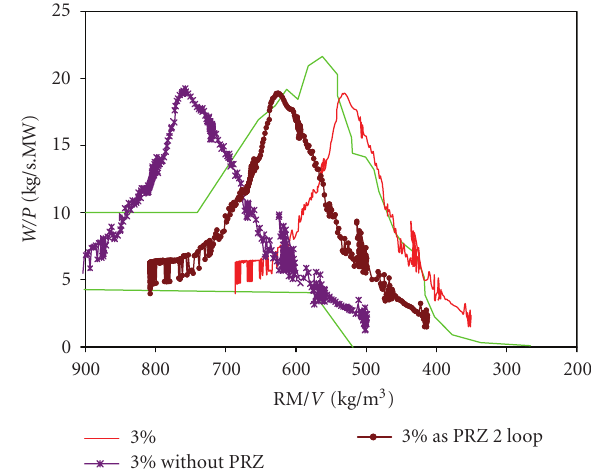
Figure 10: The e ff ect of considering di ff erent PRZ volumes on the CNA-I